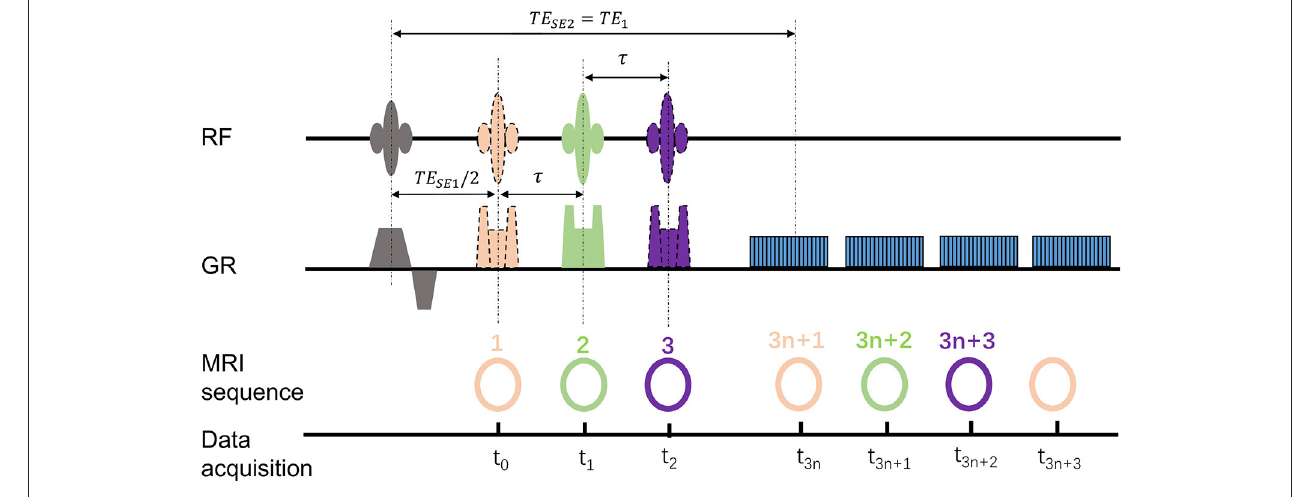
FIGURE 1 | Diagram of the psMASE sequence.